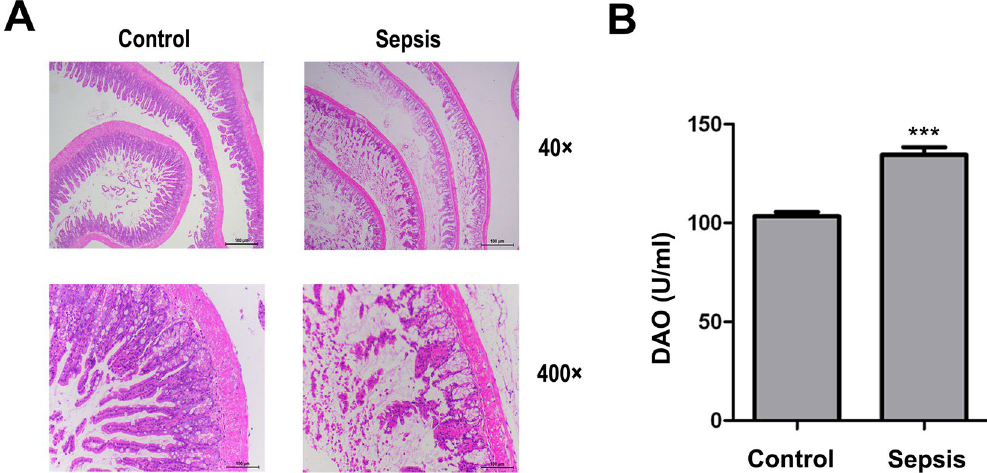
Figure 1. Sepsis-induced intestinal barrier dysfunction. ( A ) Intestinal tissue from the control and sepsis groups at 12 h after injection of LPS (haematoxylin and eosin staining); sections are representative of ten animals in each group. ( B ) DAO (a marker of intestinal permeability) concentrations in serum 12 h after administration of LPS. DAO concentrations are expressed as the mean ± SD. *** P < 0.001, control versus sepsis (n =